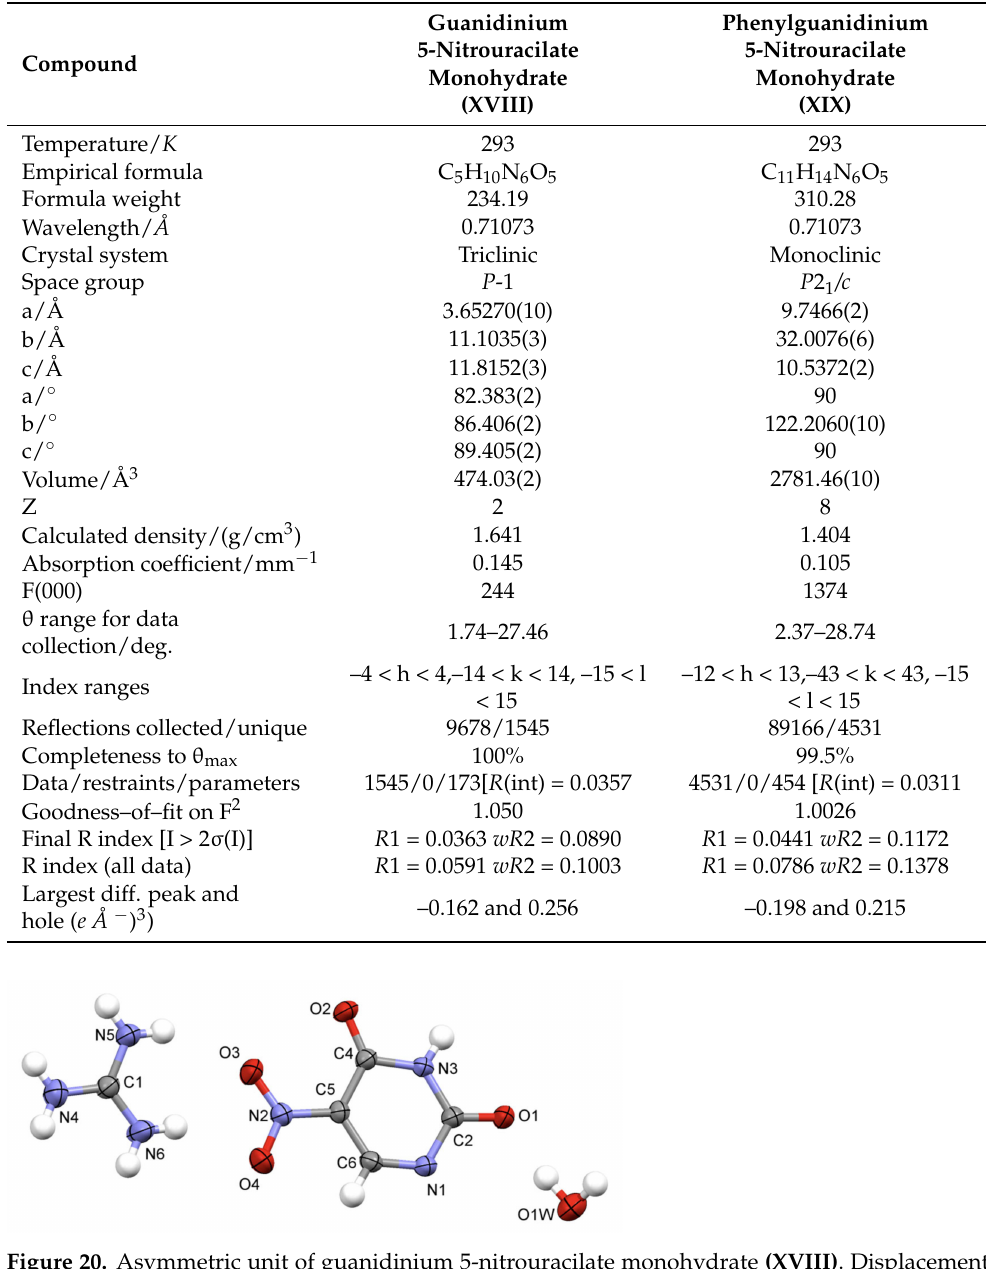
Table 7. Crystal data and structure refinement parameters for (XVIII) and (XIV) .